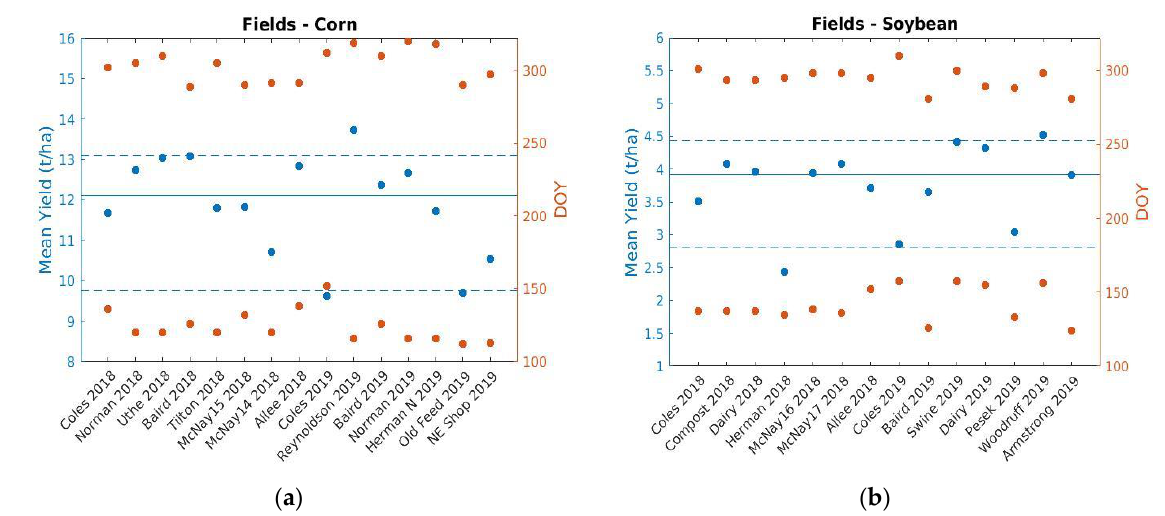
Figure 2. Per-field average yield values along with median (solid line) and 10 and 90 percentiles (dashed lines) and planting (bottom circles) and harvest (top circles) dates for corn ( a ) and soybean ( b ) fields represented as day of year (DOY).